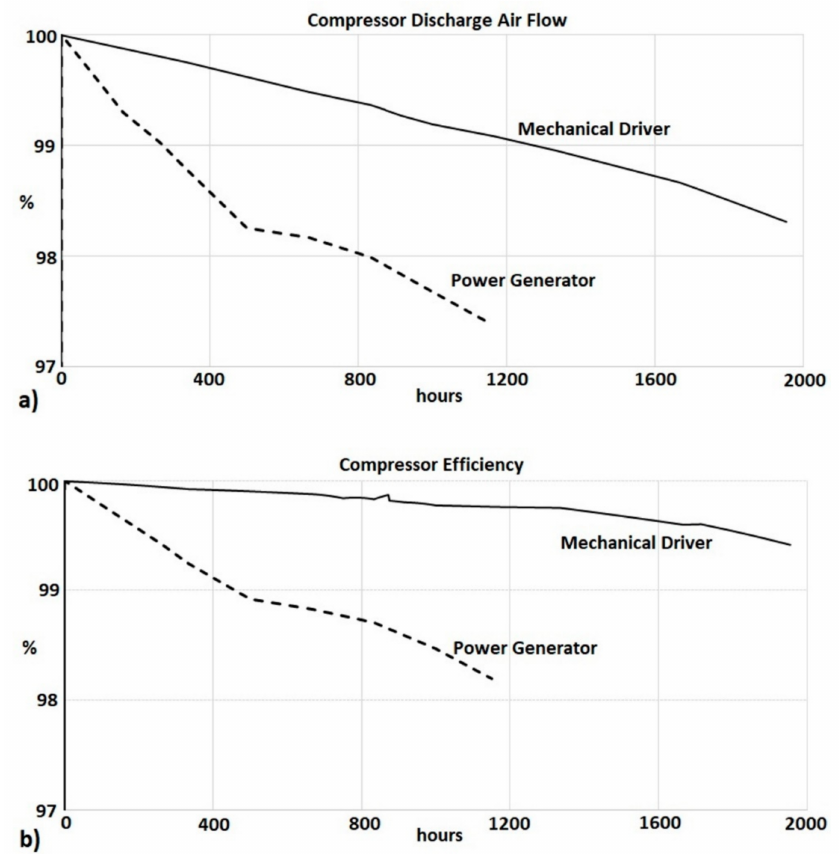
Figure 11. Estimation of dynamic reduction of health parameters during fouling conditions: ( a ) compressor discharge air flow; ( b ) compressor